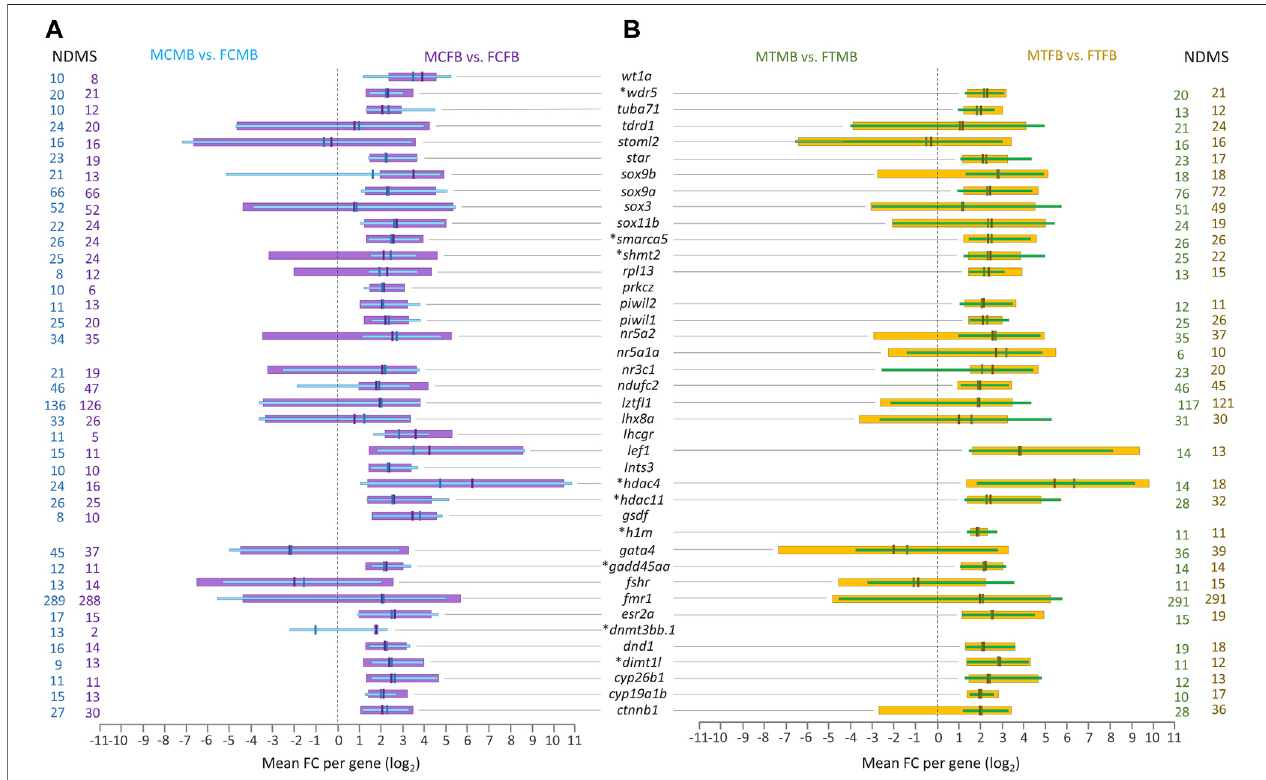
FIGURE8 | Candidate genes associated with signi fi cantly differentially methylated CpG sites in overlap between male-biased and female-biased families. (A) male control male-biased versus female control male-biased (MCMB vs. FCMB) in overlap with male control female-biased versus female control female-biased (MCFB vs. FCFB); (B) male treatment male-biased versus female treatment male-biased (MTMB vs. FTMB) in overlap with male treatment female-biased versus female treatment female-biased (MTFB vs. FTFB). This fi gure illustrates a range of at least 10 methylated positions per gene, where the number of differentially methylated sites (NDMS) for each gene is shown with the corresponding group colour. Genes involved in epigenetic mechanisms are marked with an asterisk (*). Other genes are reproduction-related genes. The x -axis represents the differences in mean fold change (log 2 FC) per gene.